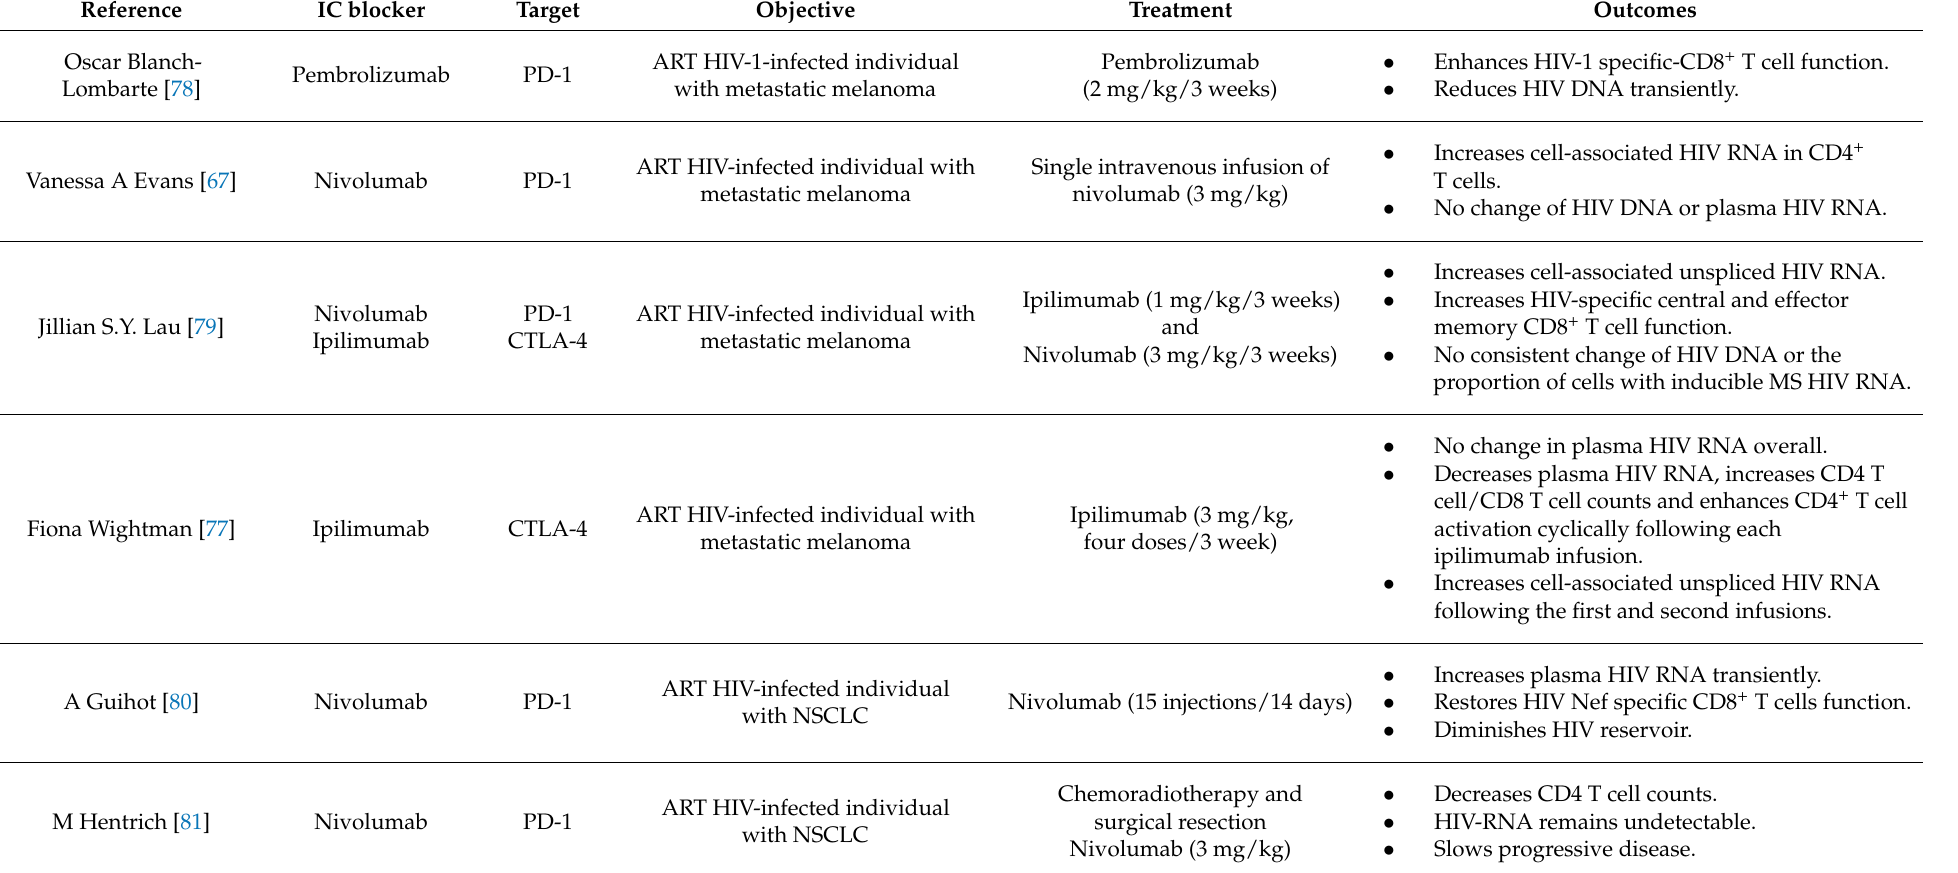
Table 3. Summary of therapeutic effects of IC blockers in HIV-infected